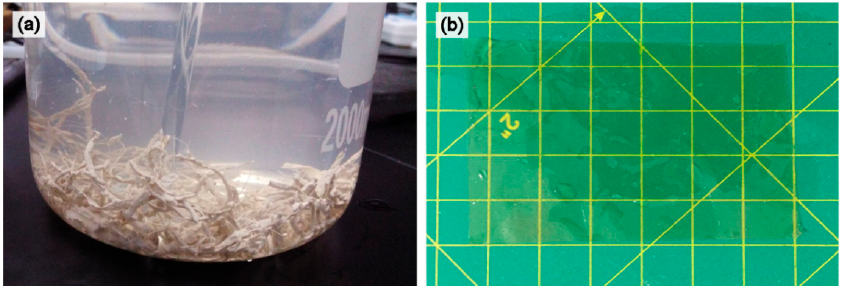
Figure 1. ( a ) Digital photo of fibrous PAEK-50 precipitated in water; ( b ) digital photo of a transparent SPAEK-50 membrane.